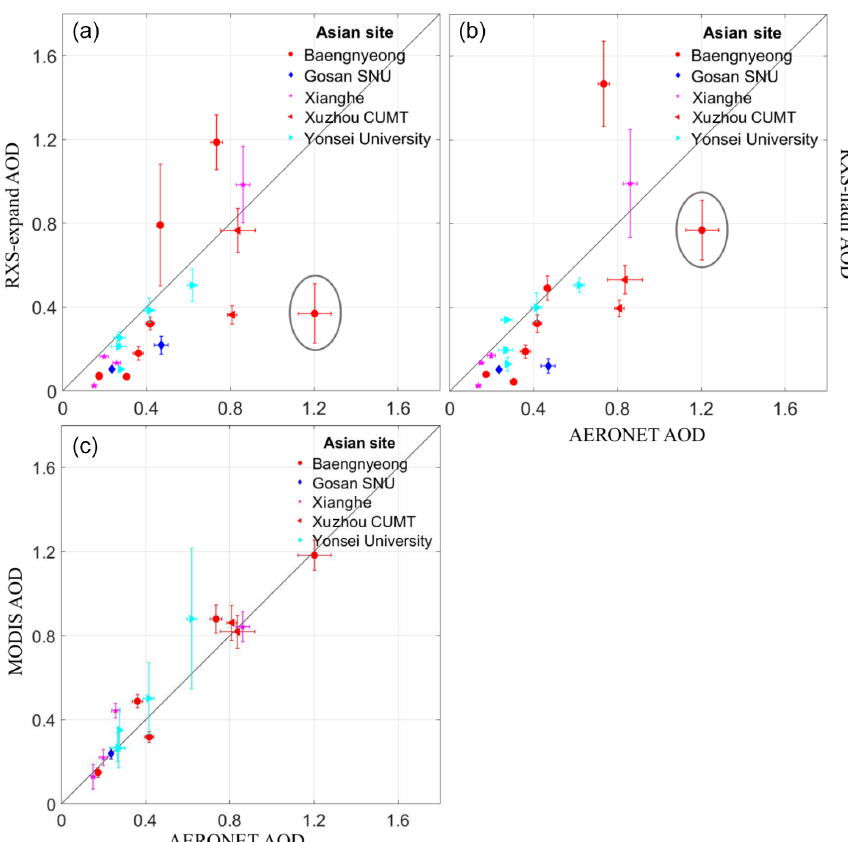
Figure 8. Comparison of collocated measurements of RXS-expand and AERONET (a) , RXS-nadir and AERONET (b) , and MODIS and AERONET (c) . Error bars in y direction indicate standard deviations of RXS-expand, RXS-nadir, or MODIS measurements within 50km of the site, and bars in the x direction indicate AERONET measurements within ± 2h of CALIPSO’s passing. Grey circles mark a notable